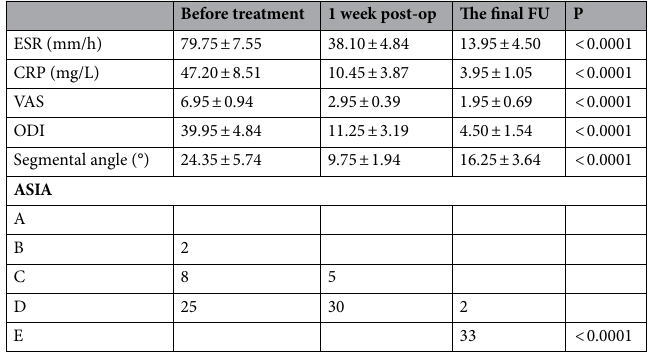
Table 2. Clinical and radiographic